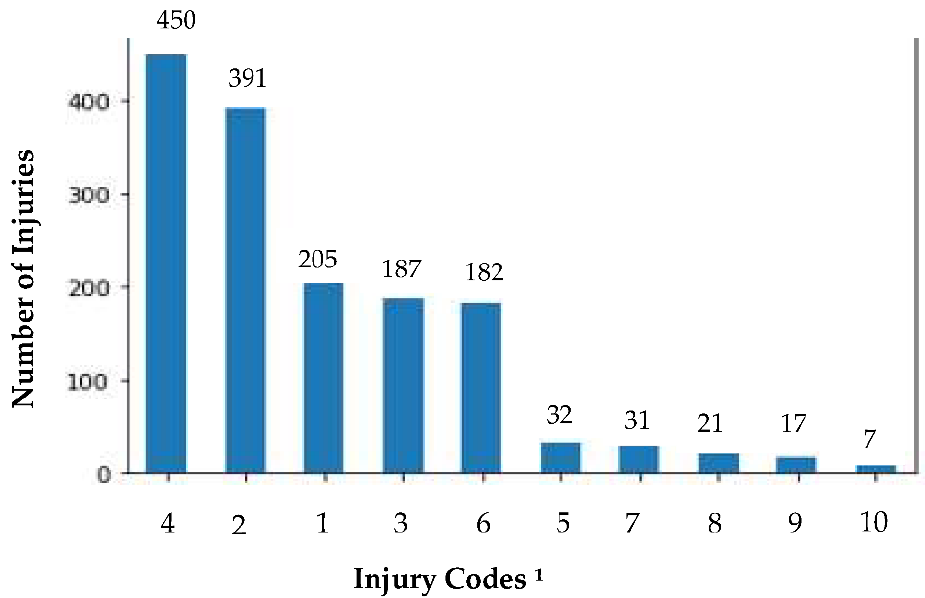
Figure 1. Distribution of categories of occupational injuries. 1 Injury Codes : 1. Head and neck region;